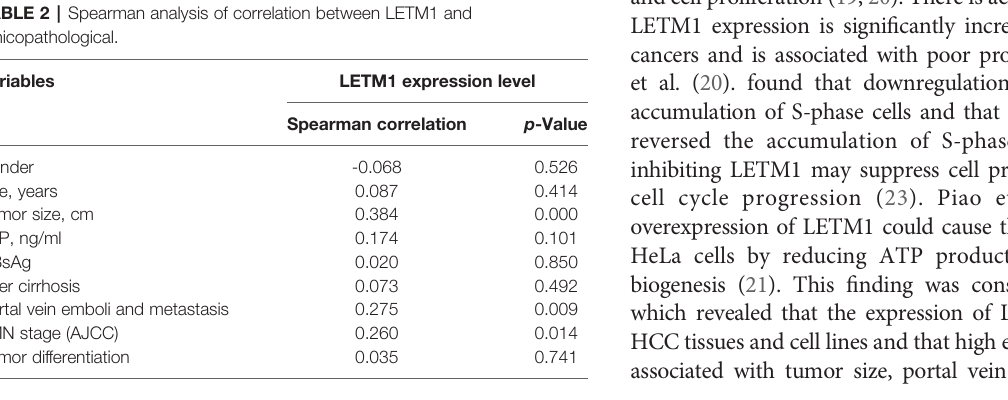
TABLE 3 | Univariate and multivariate analyses of various prognostic parameters in patients with hepatocellular carcinoma (HCC) Cox-regression analysis. LETM1